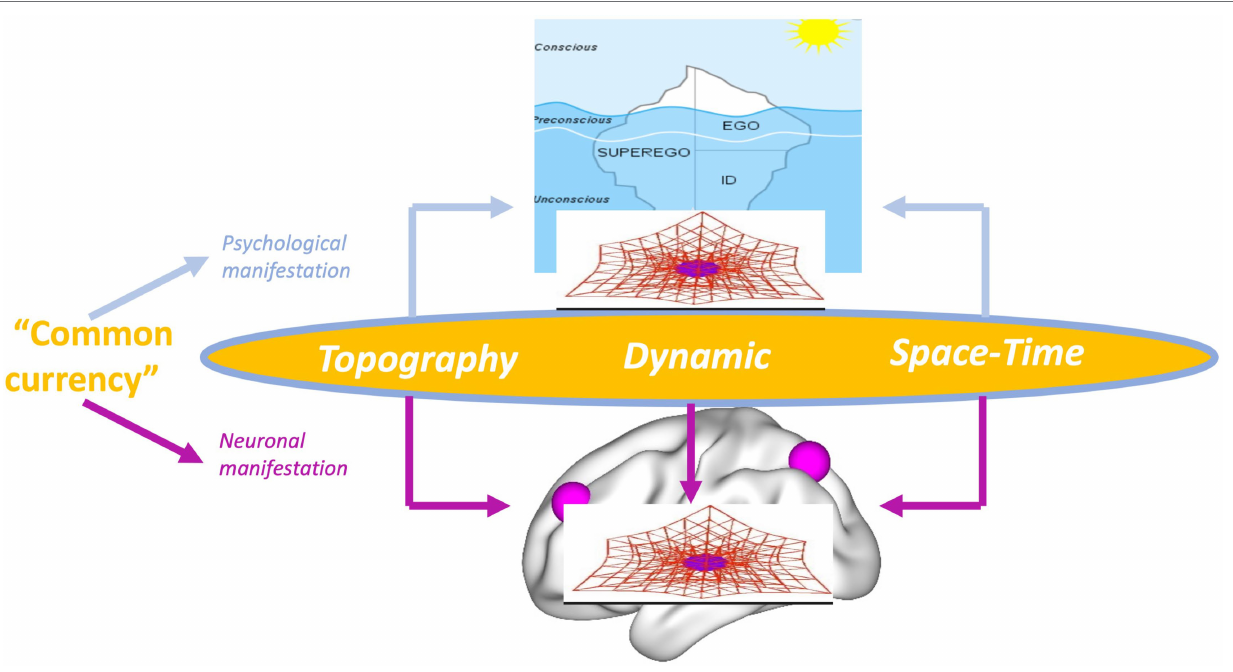
FIGURE 7 | Shared features as “common currency” (middle) of brain and (lower) and psyche